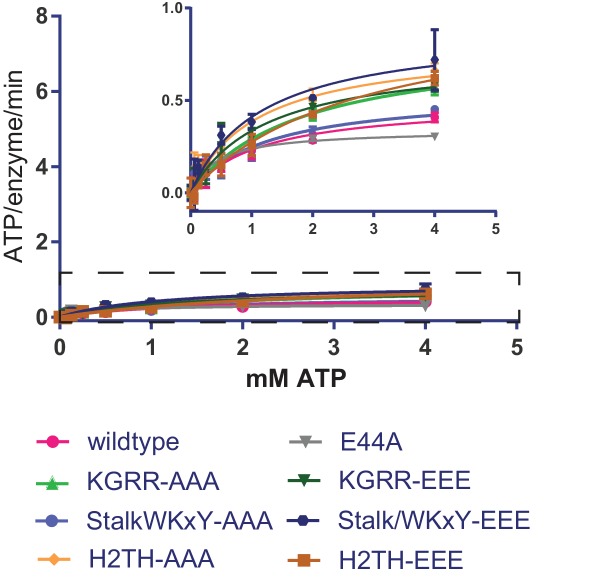
Comparison of basal ATPase activities for topo VI mutants.Rate of steady-state ATP hydrolysis measured as a function of ATP concentration for each topo VI mutant in the absence of DNA, as related to Figure 4B. Rates were determined spectroscopically using an NADH-coupled assay. Points and error bars correspond to the mean and standard deviation of three independent experiments. Numerical data are reported in Figure 4—source data 2.